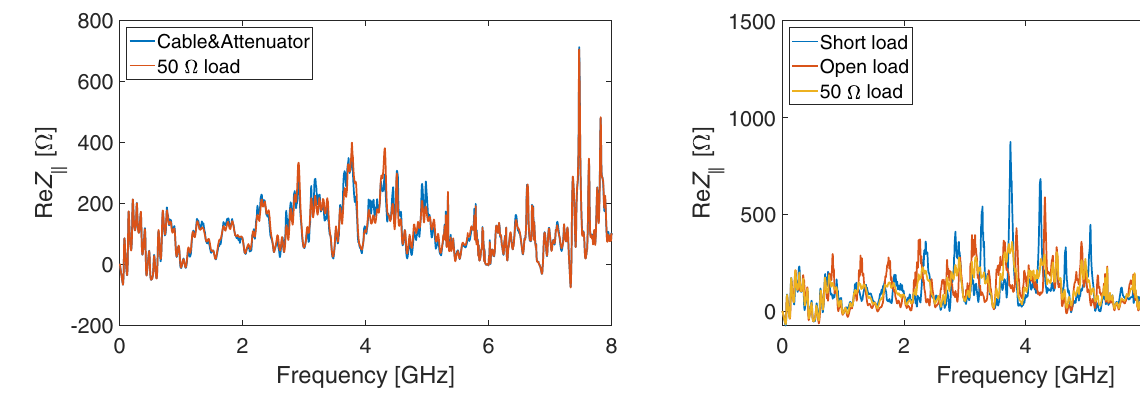
FIG. 15. The real part of the longitudinal impedance measured with different terminations on the output ports.